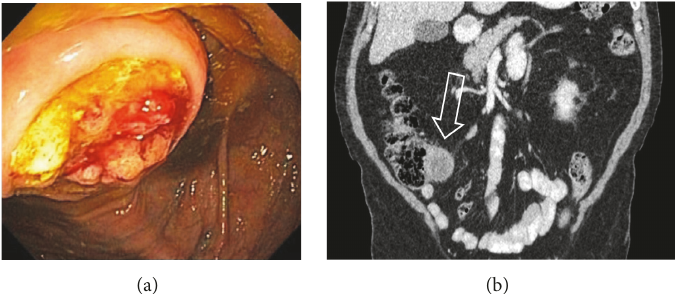
Figure 41: Endoscopic image of a primary appendiceal mucinous adenocarcinoma(a). A 6cm appendiceal mass (arrow) is seen on computer tomography (b).